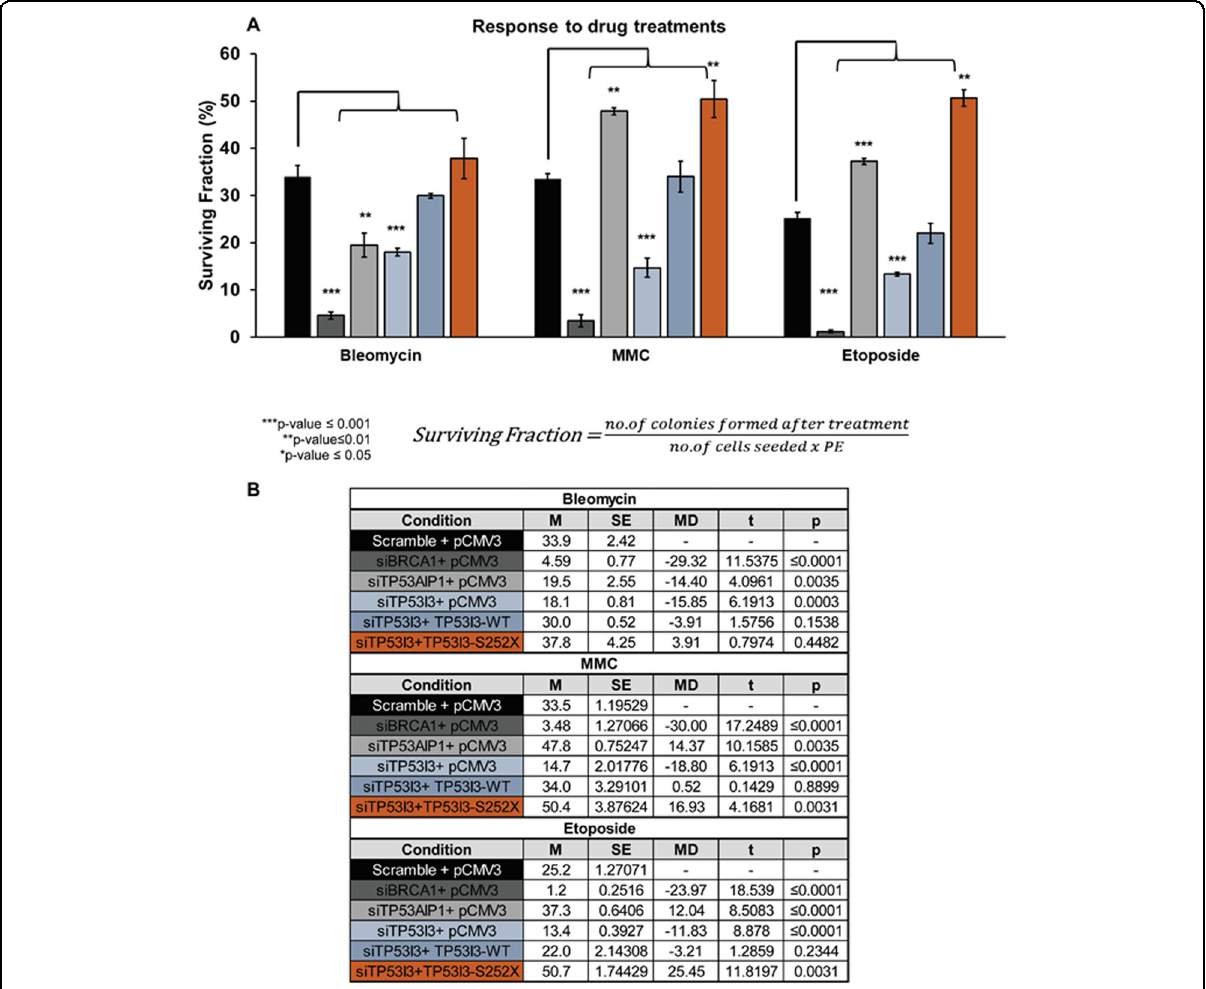
Fig. 5 Effect of TP53I3-S252X response to chemotherapy agents. A Surviving fraction ( y axis) after treatment with bleomycin, MMC, or etoposide ( x axis) incorporates plating ef fi ciency. B Calculated two-way t test for drug-conditioned cells compared with scramble-positive control. With an n = 5, p values ≤ 0.05 were considered statistically signi fi